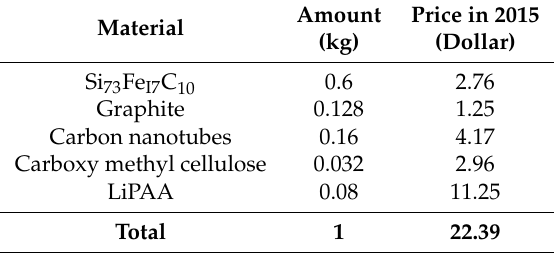
Table 7. Anode active material battery